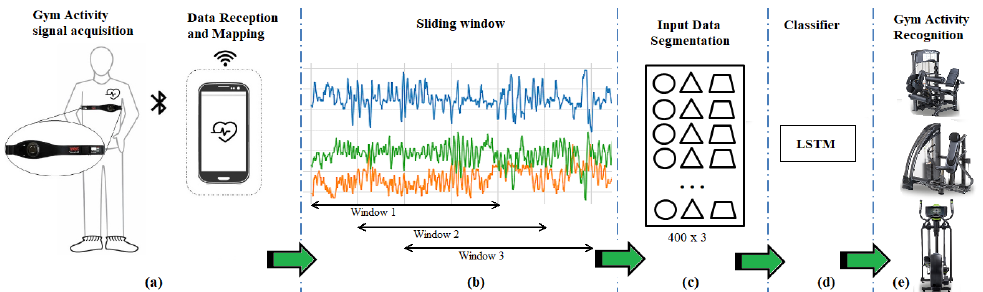
Figure 3. Architecture of the gym physical exercise recognition system, ( a ) data acquisition; ( b ) sliding window; ( c ) input segmentation; ( d ) feeding data to classifier; ( e ) gym activity